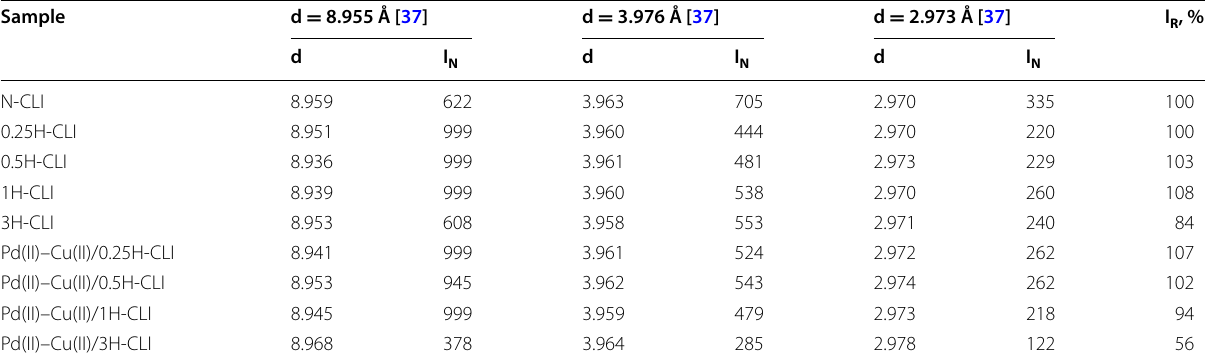
Table 1 X-ray spectral parameters for N-CLI, H-CLIs, and Pd(II)–Cu(II)/H-CLIs